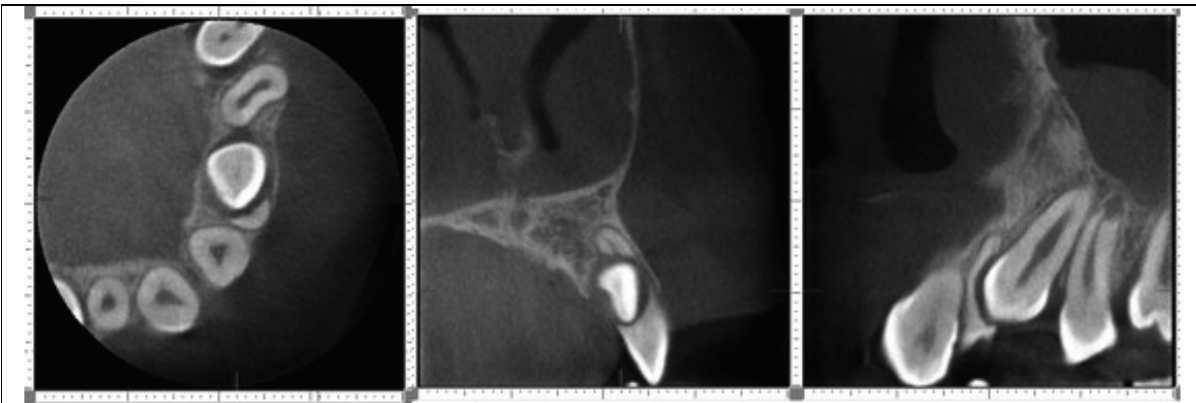
Figure 2. (A) Axial; (B) sagittal; (C) coronal views of a patient with impaction resorption of the upper left permanent lateral incisor tooth due to impacted upper left permanent canine tooth; the apical, middle and cervical thirds of the disto-palatal surface have been resorbed and the pulp has been exposed (grade